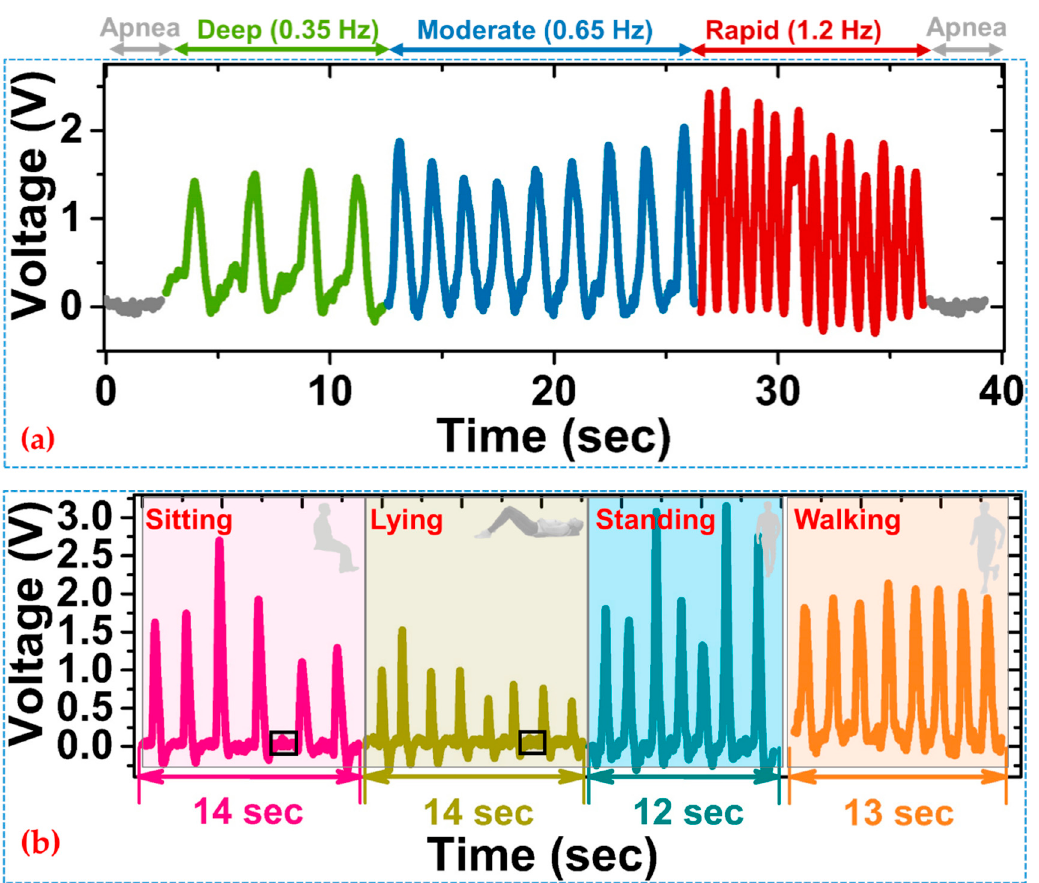
Figure 4. ( a ) Dynamic response of the sensor in different respiration modes at rest; ( b ) respiration monitoring tests for three different daily activities when the subject is (I) sitting; (II) lying; (III) standing, and (IV) walking.